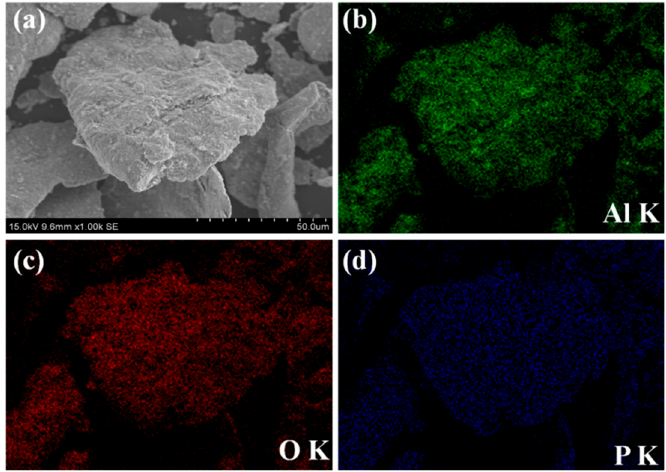
Figure 4. SEM images of ( a ) hybrid-coated powders with 8% Al 2 O 3 via ball milling and EDS maps of ( b ) aluminum, ( c ) oxygen and ( d ) phosphorus.